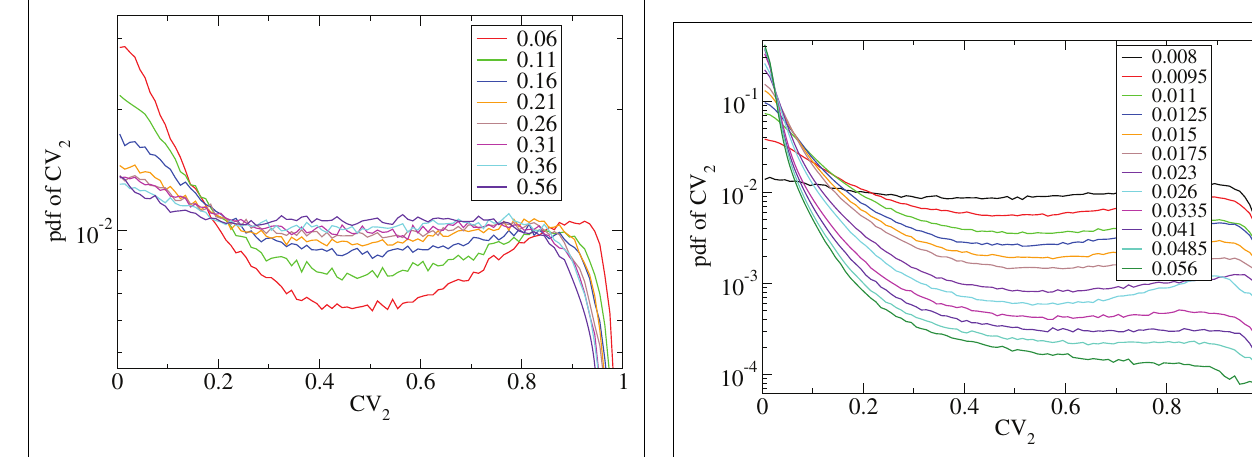
FIGURE 8 | CV 2 distributions corresponding to Figure 7 for all cells combined for different network simulations (see key.)